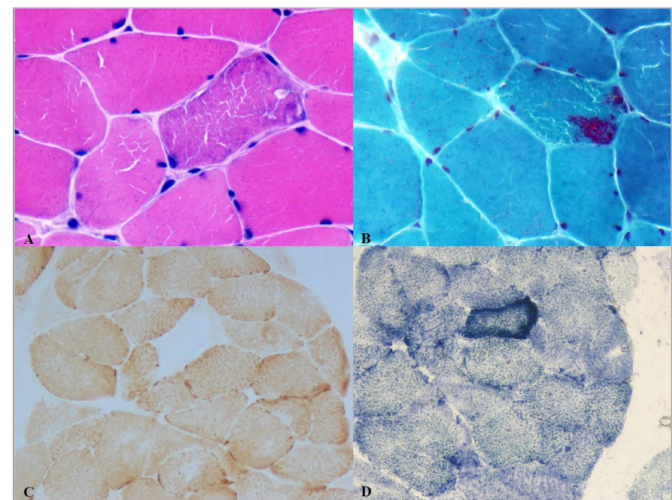
Figure 1. Histological findings in mitochondrial myopathy. ( A , B ) Ragged red fiber (Hematoxylin– Eosin and Gomori’s staining, respectively, at the center of each panel), ( C ) cytochrome c oxidase (COX)-negative fibers (“white” fibers, COX staining), and ( D ) “Ragged blue” fibers (SDH (succinate dehydrogenase)